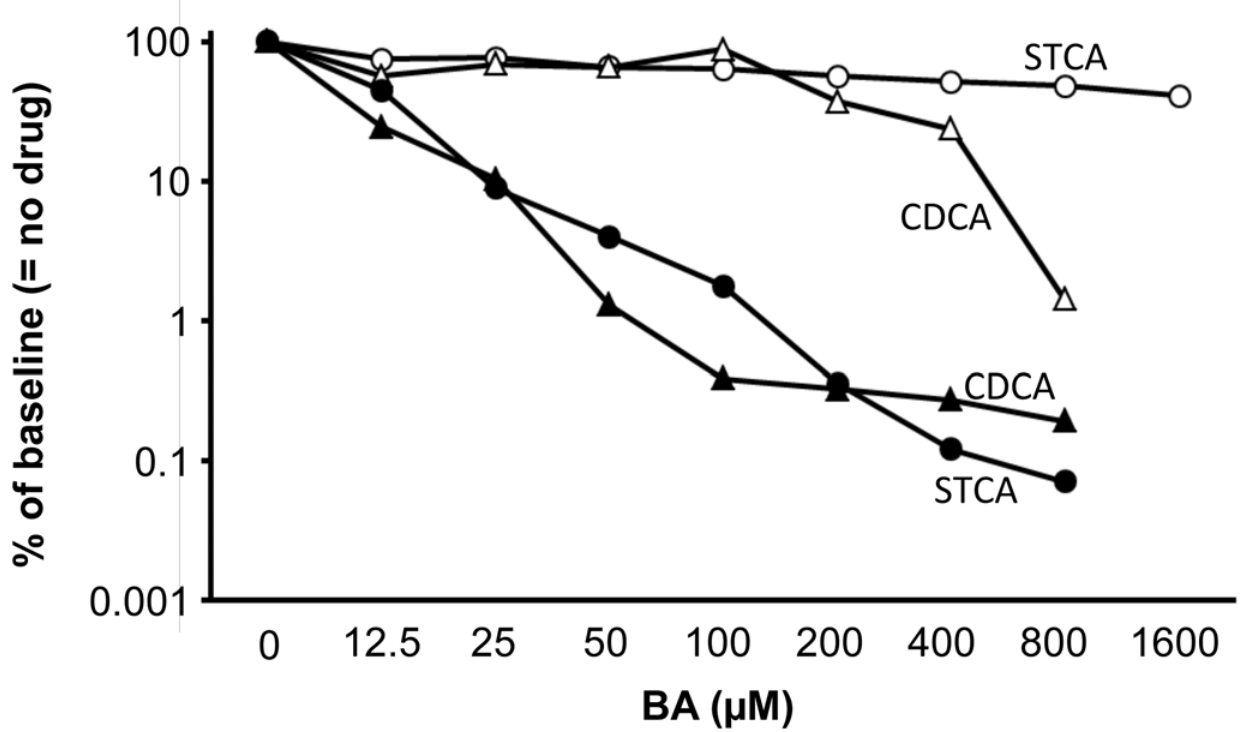
Fig 3. Inhibition-toxicity relationship for chenodeoxycholic acid and sodium taurocholate. To assay HDV infectivity (filled symbols) HuH-7/hNTCP cells were infected as described above in a 96-well plate and TCID 50 was performed in the presence of increasing concentrations of chenodeoxycholic acid (CDCA; triangles) or sodium taurocholate (STCA; circles). In parallel, using identical concentrations and duration of exposure HuH-7/hNTCP cells stably expressing firefly luciferase were treated with CDCA or STCA and luciferase activity after drug treatment was measured as an aggregate measure of cytotoxic and anti-proliferative effects (open symbols). A representative of three independent experiments (only two for cytotoxicity) is shown. Each data point is based on analysis of 48 wells in a TCID 50 setup.